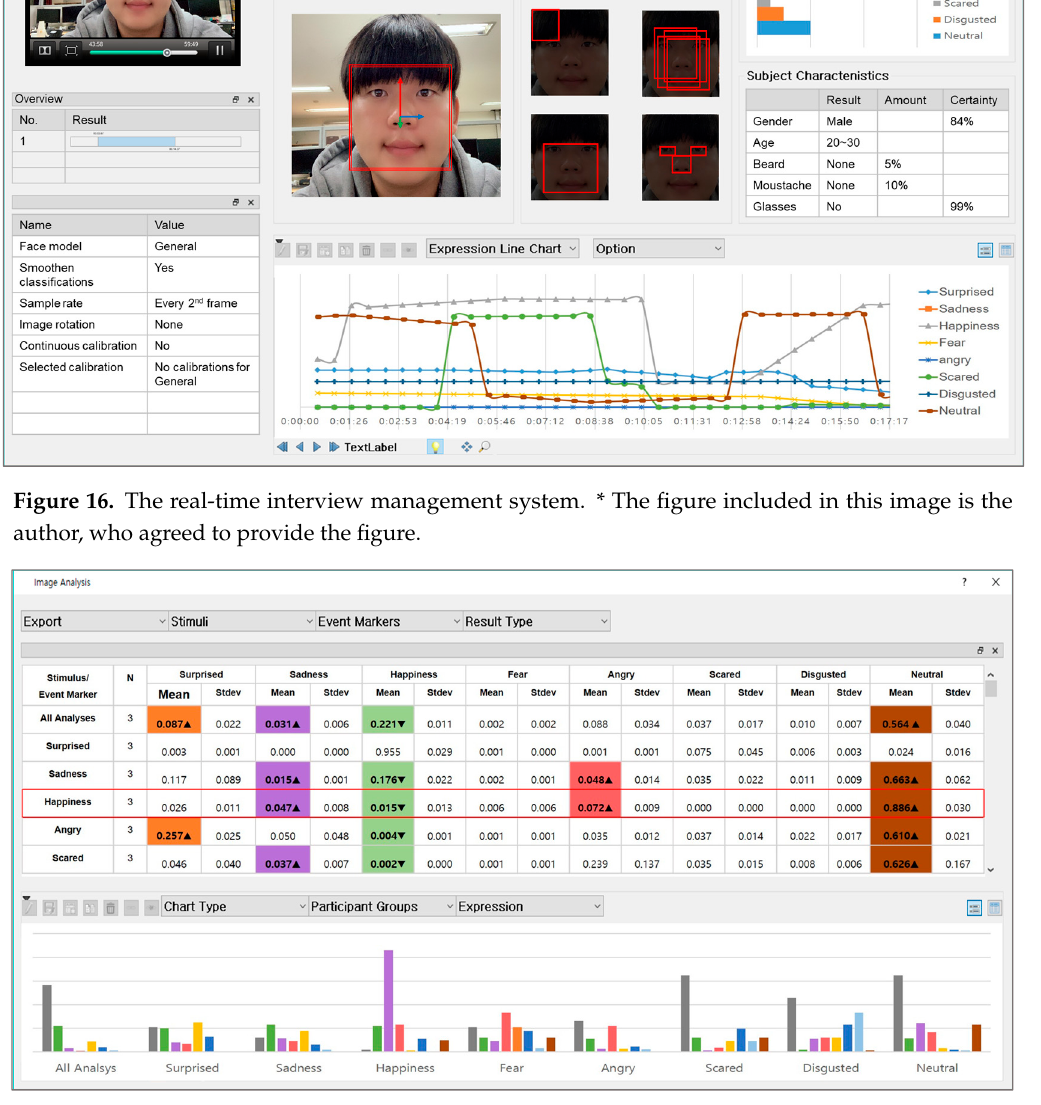
Figure 17. Facial recognition and emotion analysis results from the interview management system.